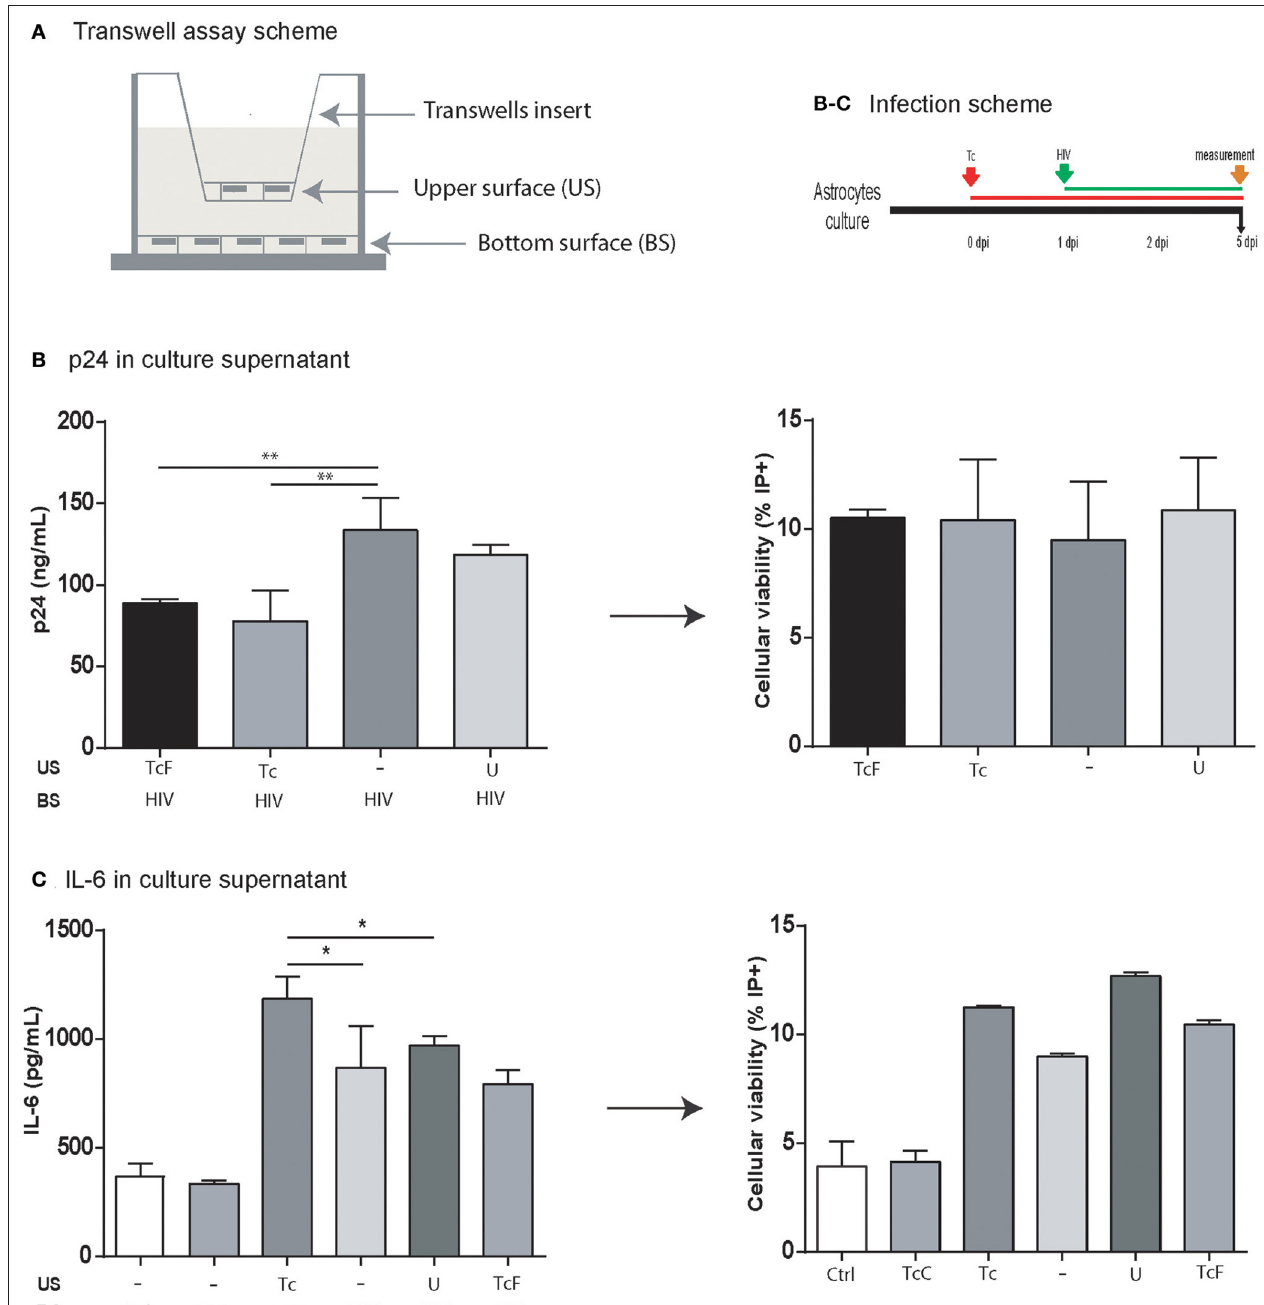
FIGURE 7 | Impact of the soluble factors on HIV replication and IL-6 level. (A) Schematic depiction of the setup for a transwell assay with the upper surface (US) separated from the bottom surface (BS) by a membrane with 0.4- µ m pores. (B) p24 antigen level (ng/mL) in culture supernatant in four different conditions. All cells in the bottom surface were infected with HIV. Four different conditions were fixed to the upper surface: (i) T. cruzi free stage (trypomastigote) (TcF), (ii) astrocytes infected with T. cruzi (Tc), (iii) empty ( − ), and (iv) uninfected astrocytes (U). The cell viability in the bottom surface was measured by propidium iodide (PI + ) by flow cytometry at 5 dpi (** P < 0.01). (C) IL-6 level in the culture supernatant was measured in six different conditions. In the bottom surface, cells were infected with HIV ( + ) except for two of them (Ctrl: uninfected cells; TcC: cells infected with Tc only). In the upper surface, astrocytes infected with T. cruzi (Tc), empty ( − ), uninfected astrocytes (U), and T. cruzi free stage (trypomastigote) (TcF). The cell viability in the bottom surface was measured by propidium iodide (PI + ) by flow cytometry at 5 dpi (* P < 0.05, and ** P < 0.01).